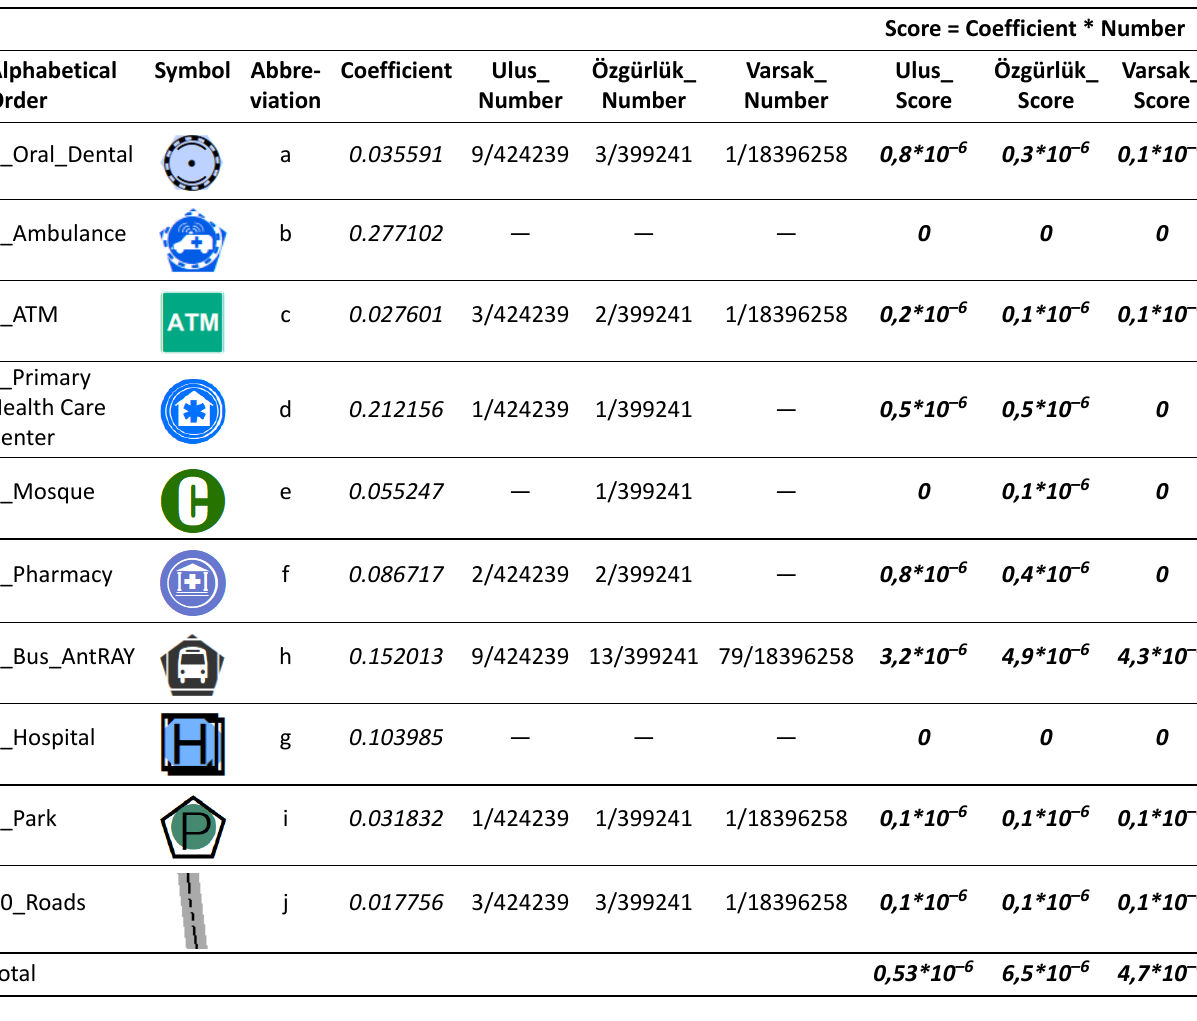
Table 6. Liveability score table according to area